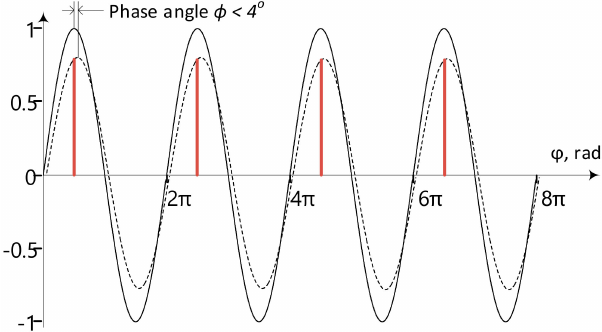
Figure 9. Sampling | V ( i ) | in case of small phase angle of the impedance vector using only positive half periods. Solid line is unity magnitude excitation current, dashed line is response voltage. Samples related to the R e V(i) are in red